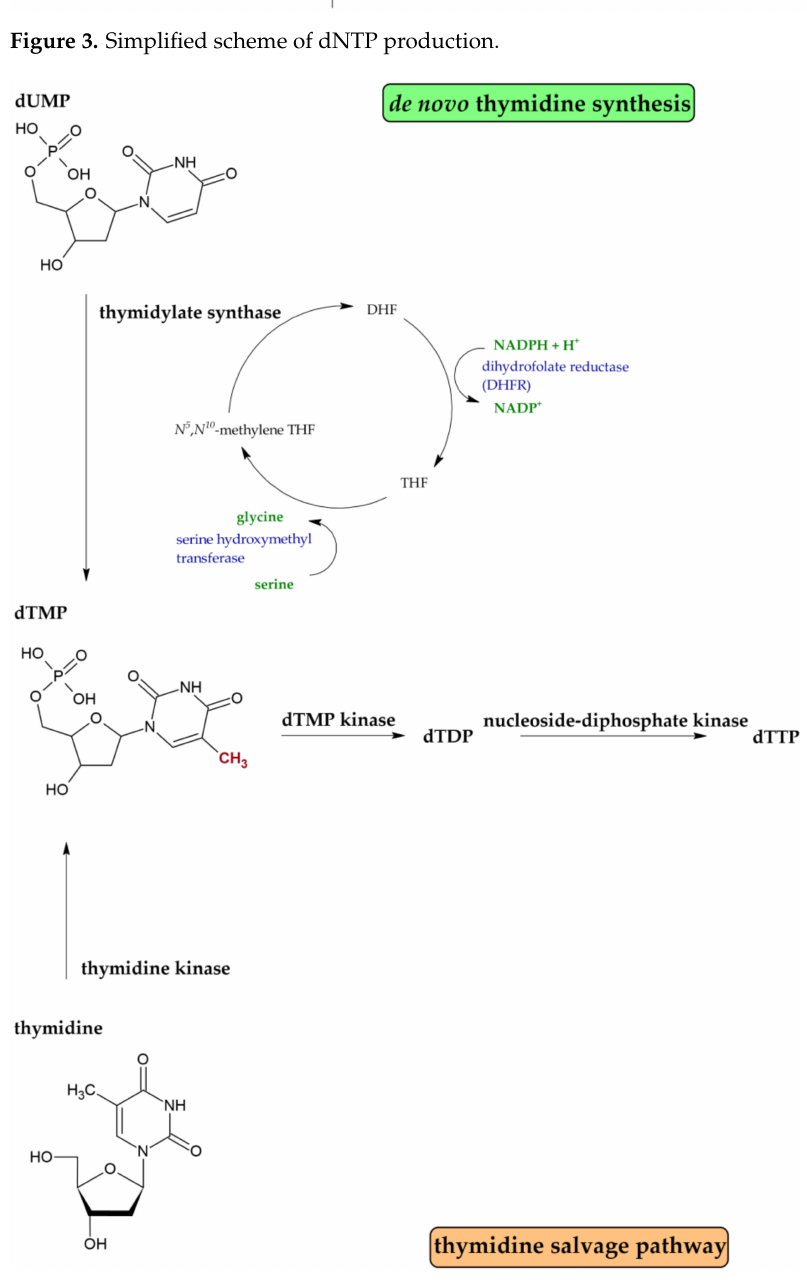
Figure 4. Simplified scheme of dTTP production by de novo synthesis or the salvage